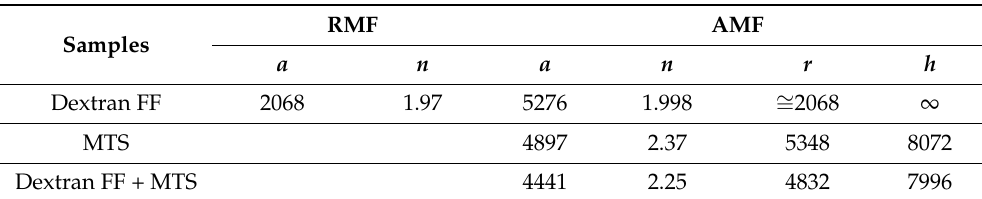
Table 1. Numerical values of parameters a and n , a power function of the d T /d t = ( H/a ) n type for samples determined in RMF and in AMF.